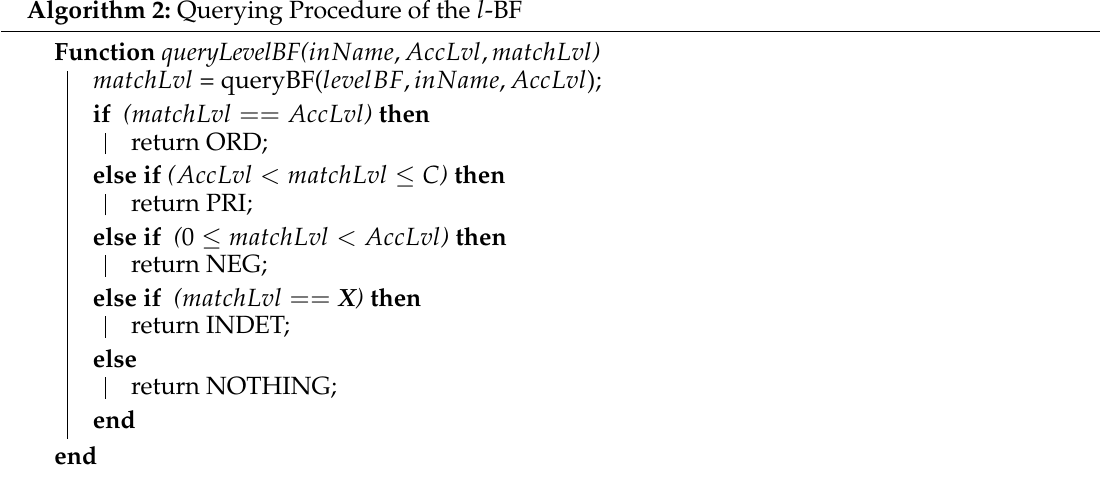
Algorithm 2: Querying Procedure of the l -BF